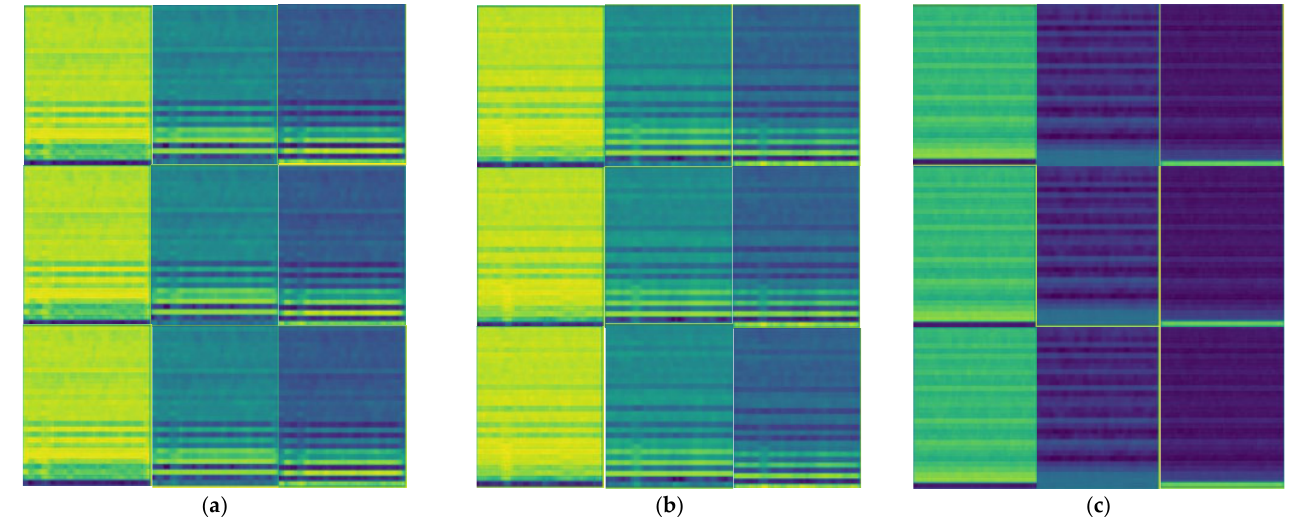
Figure 11. Feature map in stage 4 of RepVGG: ( a ) RE damage; ( b ) OR damage; ( c ) MRE damage. Table 7. Diagnosis accuracy and reasoning time.